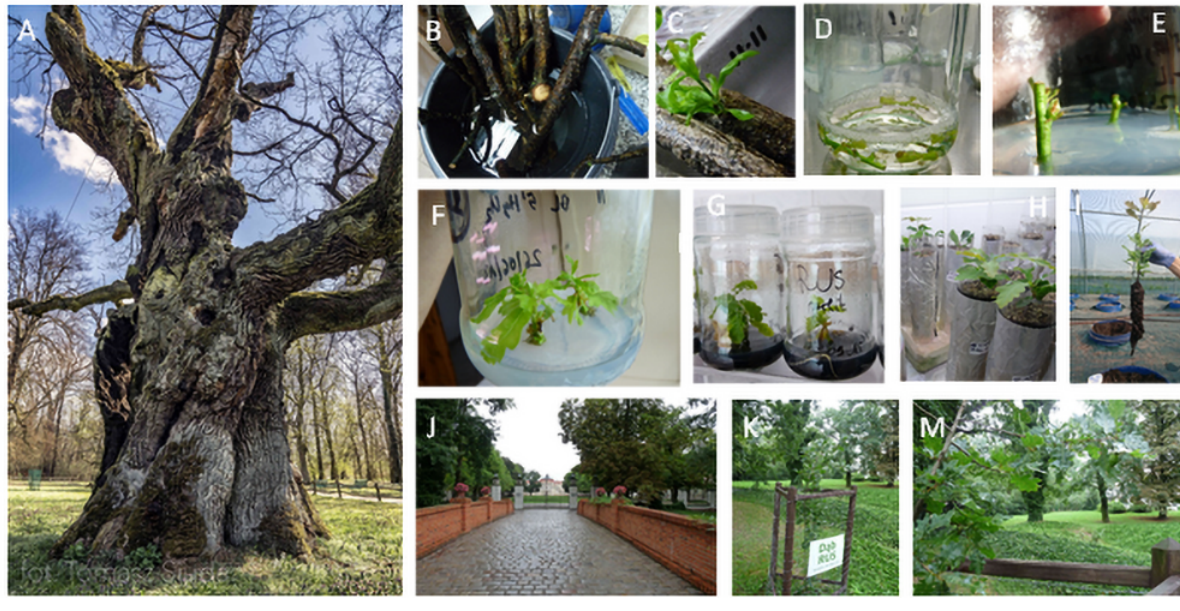
Figure 5 ( A ) 800-year-old oak Rus ( Quercus robur L.) growing in Rogalin (photograph: Tomasz Siuda). ( B ) Fragments of woody shoots collected from the old tree in late April 2014. Samples were kept in water-filled containers in a growth chamber with high levels of humidity at 25 °C for the preparation of explants. ( C ) Young epicormic shoots developed from sleeping buds of woody branches (1-month-old explants). ( D ) Disinfection of 2 cm-long fragments of epicormics shoots, from which leaves were removed (explants for initiation of in vitro culture). ( E ) Sterile shoots with one–two buds cultured in vitro on woody plant medium containing cytokinins (6-benzylaminopurine) (initiation of in vitro culture). ( F ) Multiplication of shoots in sterile conditions, in light, at 23 °C. ( G ) Rooted shoots and rooting medium with activated carbon [rooting of shoots (minimum 2.5 cm in high) in vitro]. ( H ) Acclimated plantlets growing in high containers with solid medium, with new leaves visible. ( I ) e clone of oak Rus derived in vitro (the same genotype of root and shoot), planted into a 120-litre container. ( J ) e National Museum in Poznań – Rogalin Palace, where the clone of oak Rus was planted in April 2019. ( K ) A 4-year-old oak tree, a clone of oak Rus. ( M ) e first acorns appeared on the tree very early (in 2021), serving as a reminder of the real genetic age of the